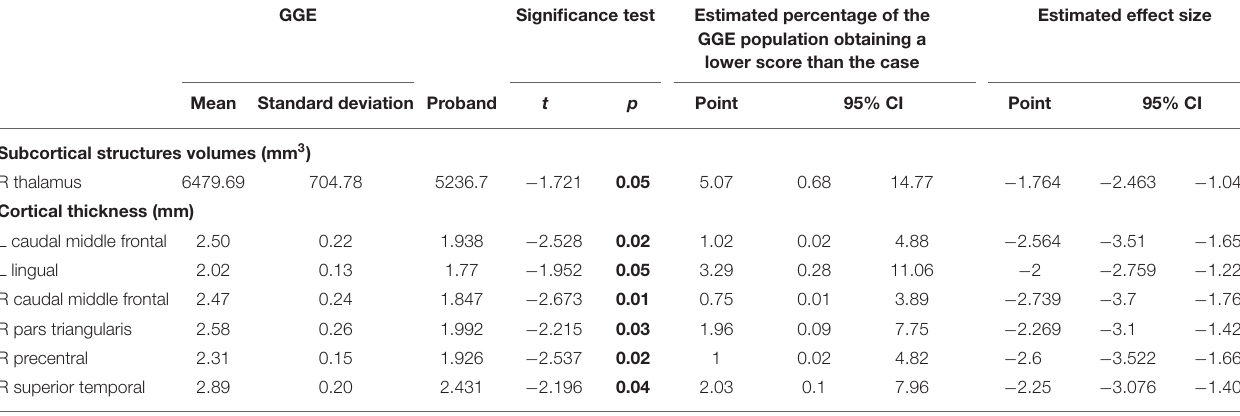
p-values are written in bold.